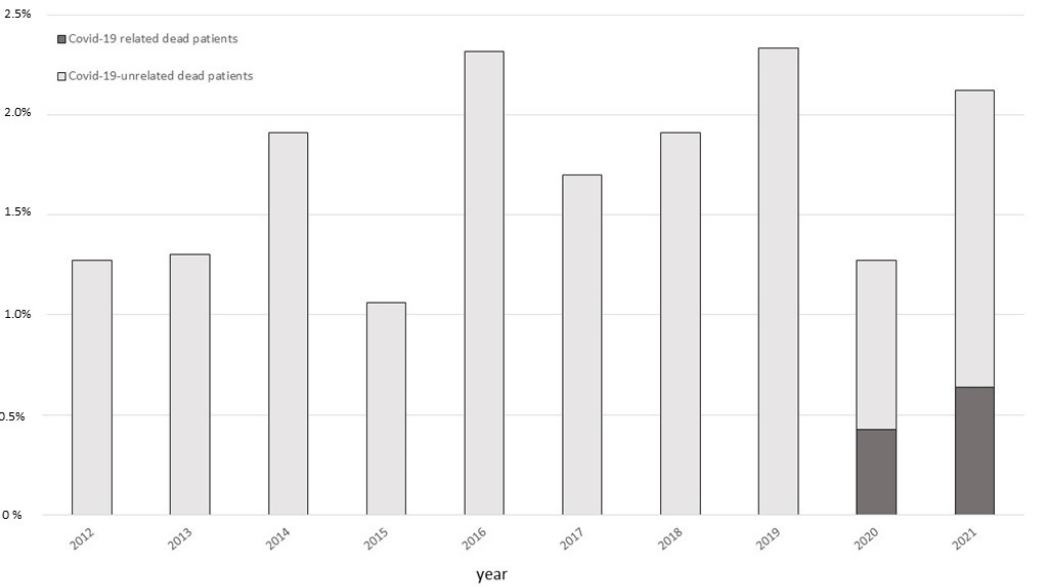
* chronic lung disease stands for fatal exacerbation of end-stage respiratory failure in chronic lung disease, without a definite microbiological isolation.